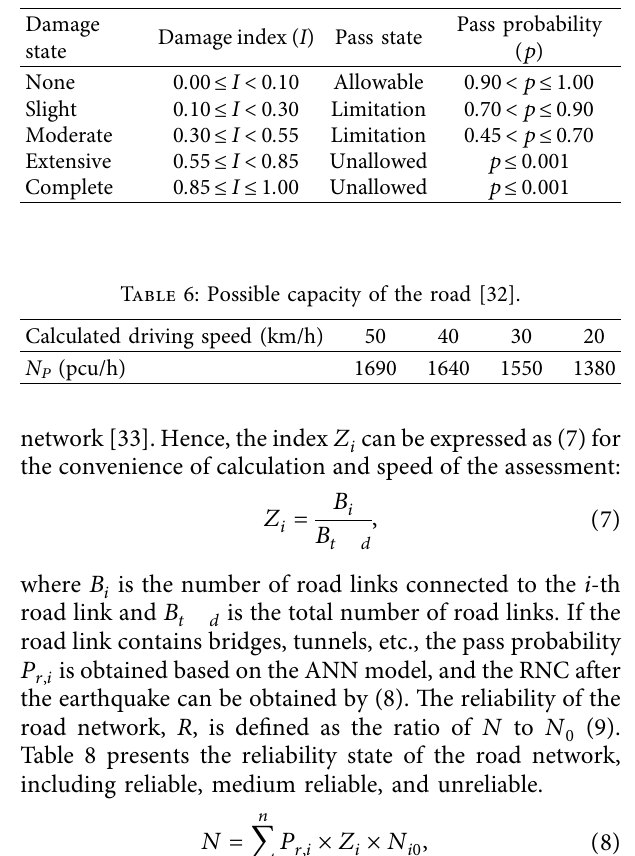
Table 5: The relationship between the damage index and the damage state.